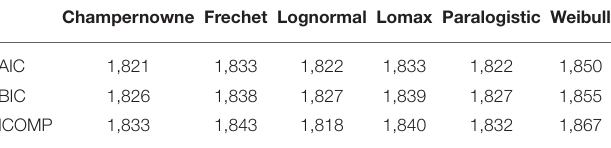
TABLE 5 | Simulation: Information criteria for Champernowne, Frechet, Lognormal, Lomax, Paralogistic, and Weibull models. Champernowne Frechet Lognormal Lomax Paralogistic Weibull AIC 1,821